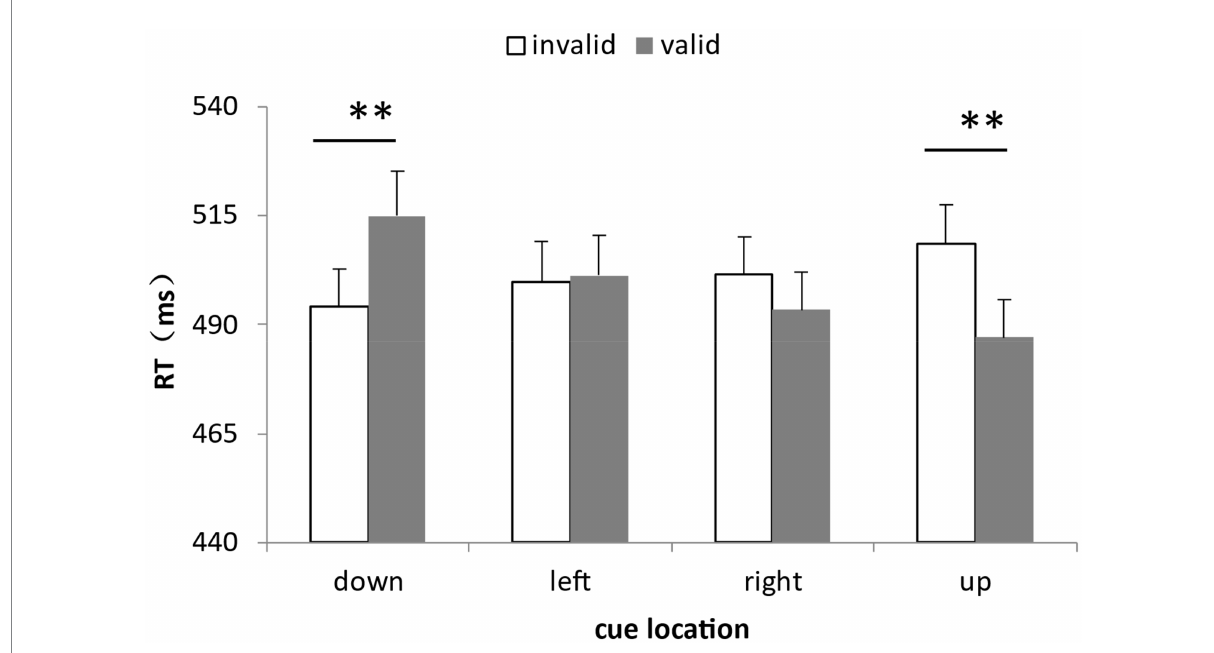
FIGURE 8 Interaction between cue validity and cue location in Experiment 3. When the cue appeared in the lower position, the response when the cue was invalid was faster than that when the cue was valid; when the cue appeared in the upper position, the response when the cue was invalid was slower than that when the cue was valid; and when the cue appeared on the left and right side, there was no difference between the response when the cue was invalid and the response when the cue was valid (** p <